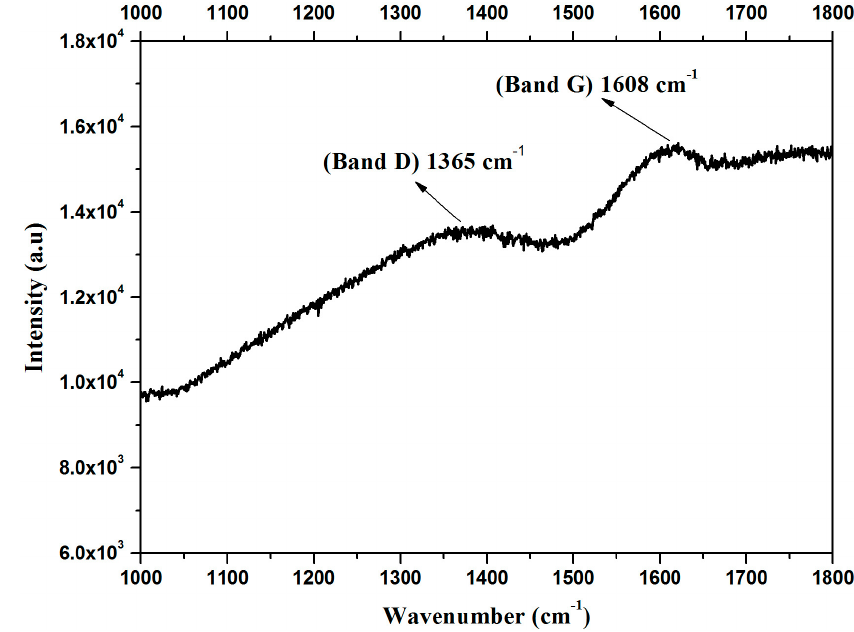
Figure 3. Raman spectrum of the peat talc sample.